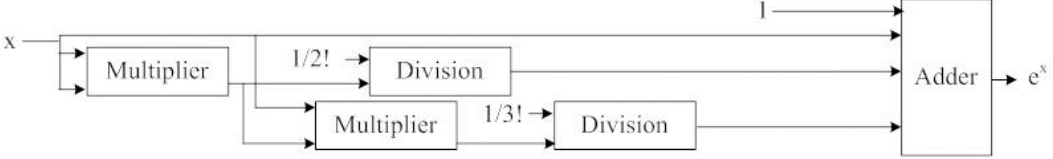
Figure 5. Block diagram of exponential function with Taylor expansion.